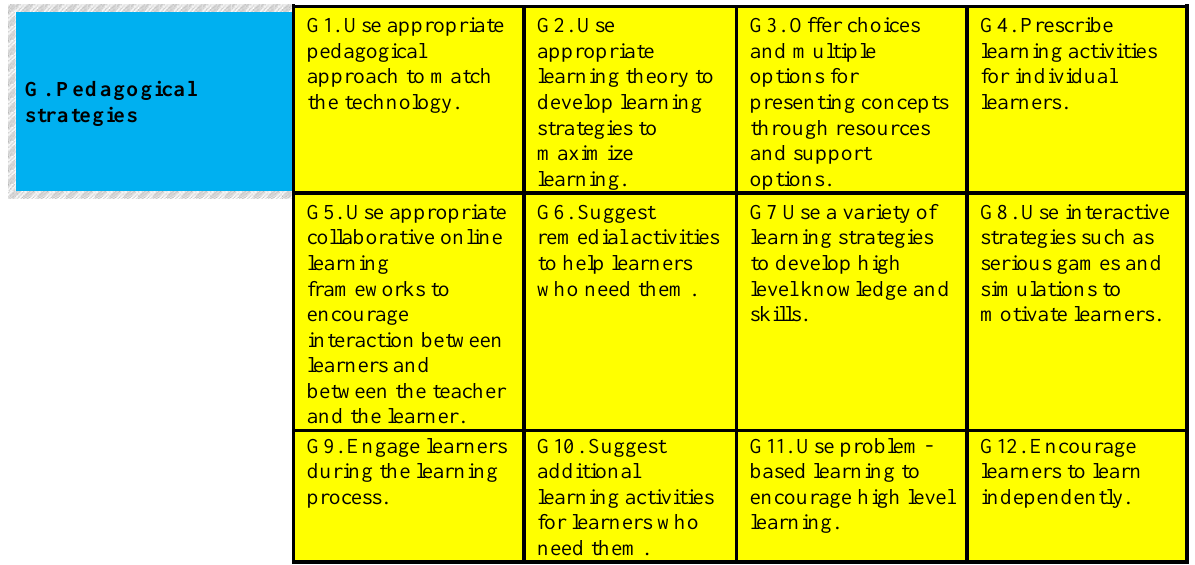
Figure 9. Pedagogical strategies competencies for the digital